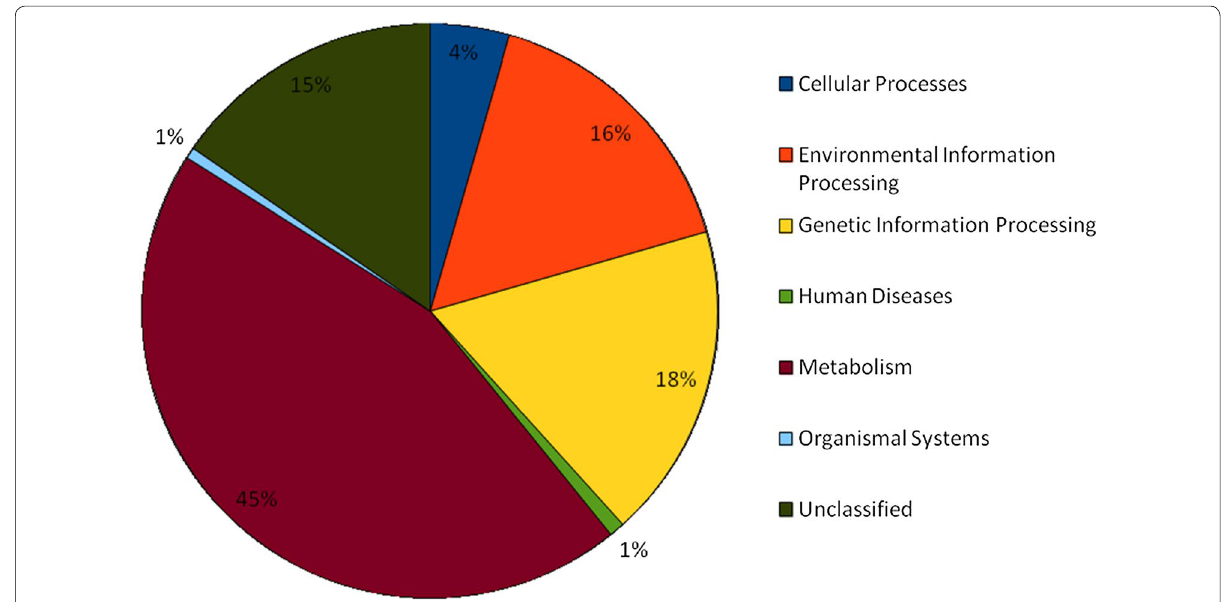
Fig. 6 Distribution of KEGG pathway in sa - um metagenome